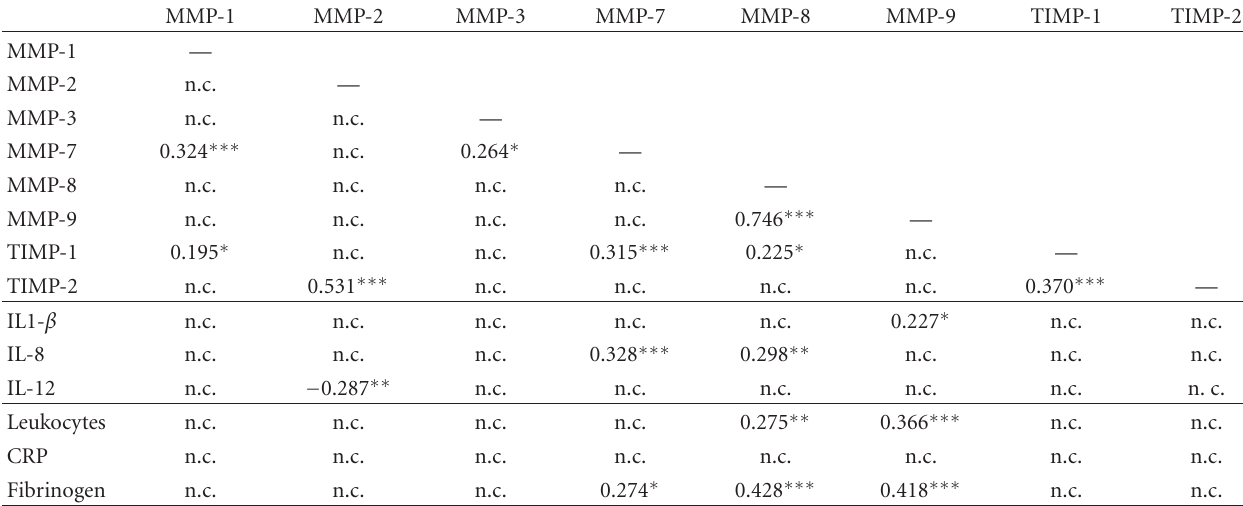
Table 3: Correlation analysis for various blood parameters.